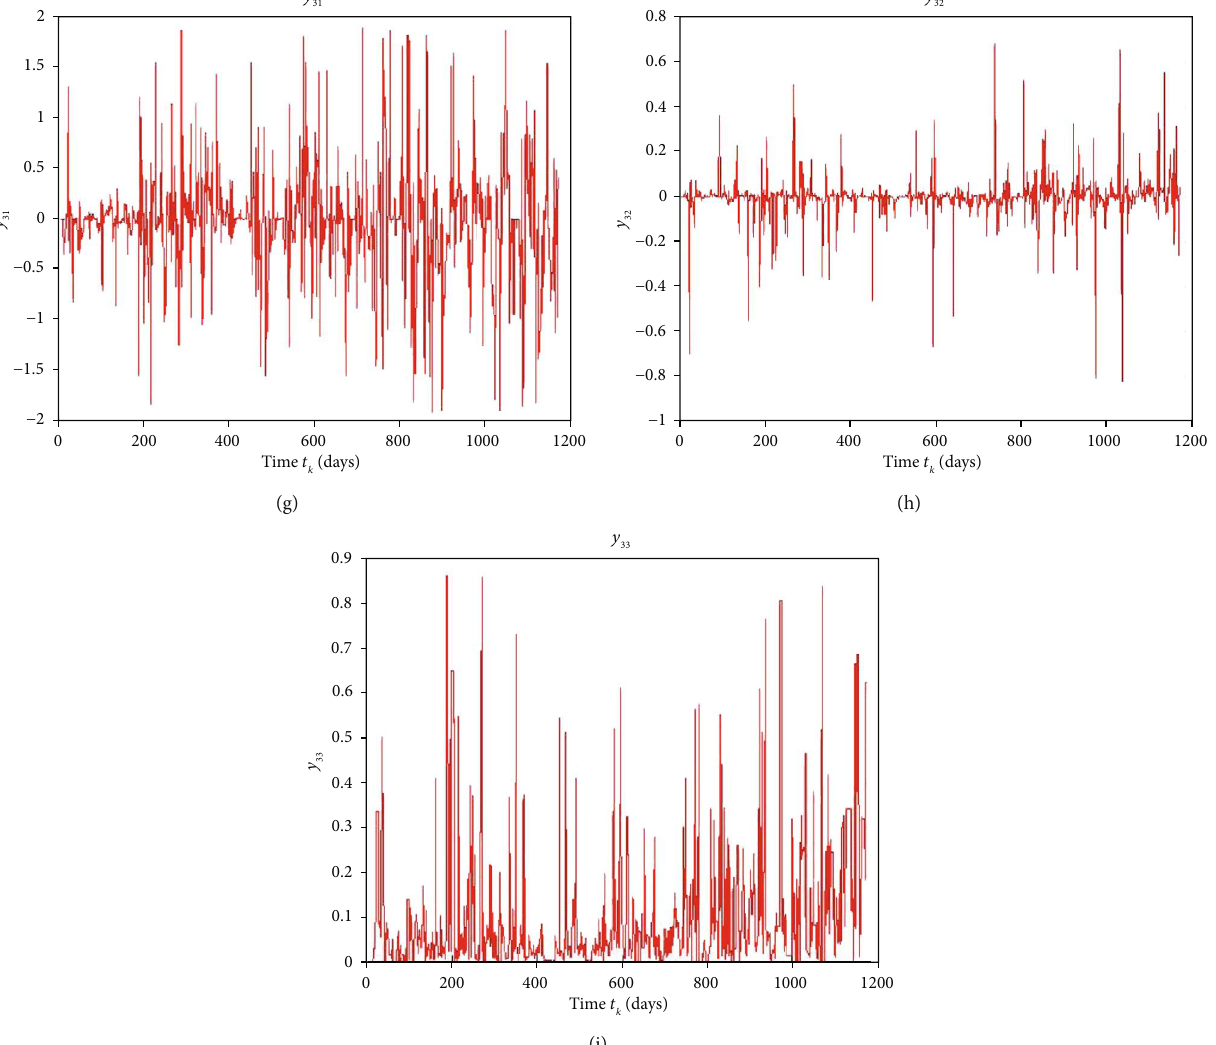
Figure 11: The graph of interaction coe ffi cients γ and γ